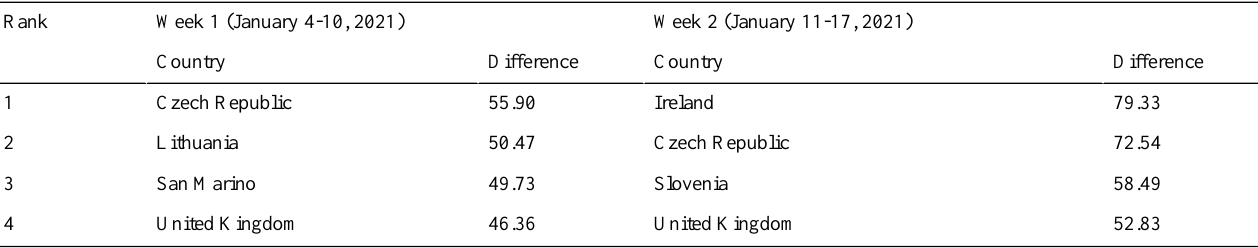
Table 6. Difference in 7-day persistence between the two study